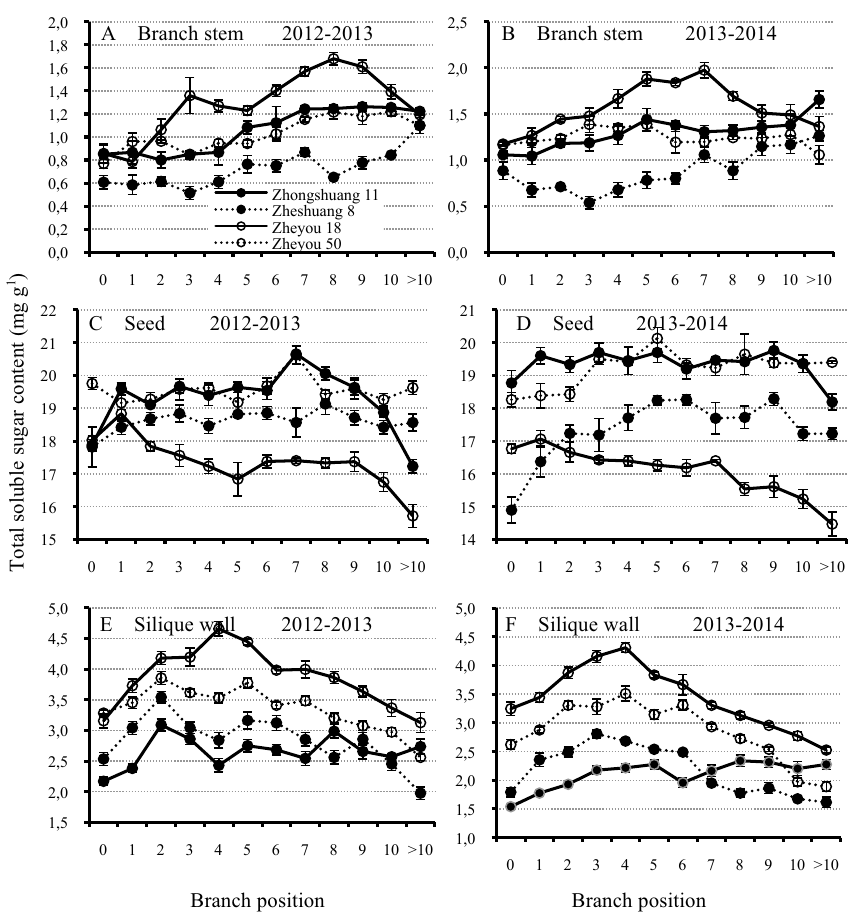
Fig. 3: Total soluble sugar content in the main inflorescence and different branches from the top to the bottom of the main stem in the branch stem in (A) 2012-2013 and (B) 2013-2014, seed in (C) 2012-2013 and (D) 2013-2014, and silique wall in (E) 2012-2013 and (F) 2013-2014 growth seasons in the four cultivars, Zheyou 50, Zhongshuang 11, Zheyou 18, and Zheshuang